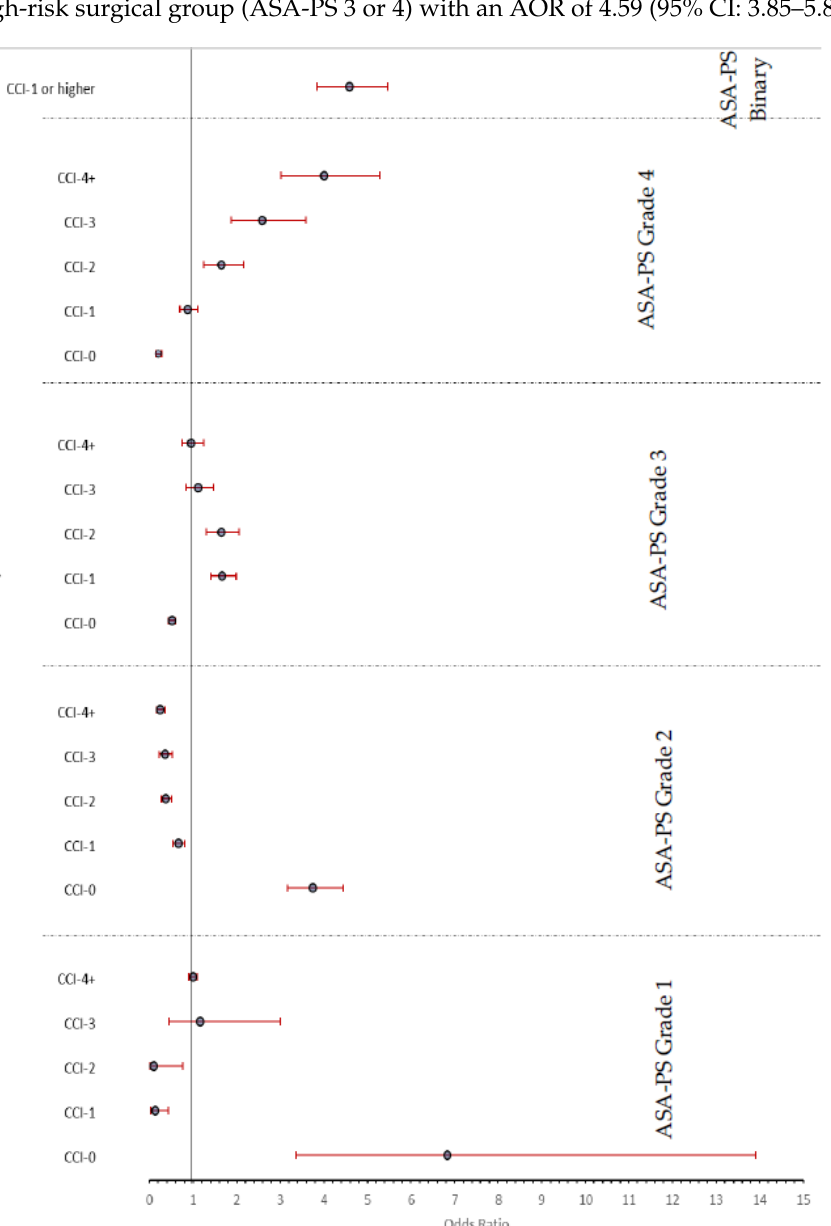
Figure 2. The likelihood of each Charlson Comorbidity Index predicting each of ASA-PS grades 1 to 4 among adults with geriatric trauma injuries using the training dataset. Each CCI index was a predictor dummy variable assessing each category of ASA-PS grades with each model selected using LASSO forward-selection tools.